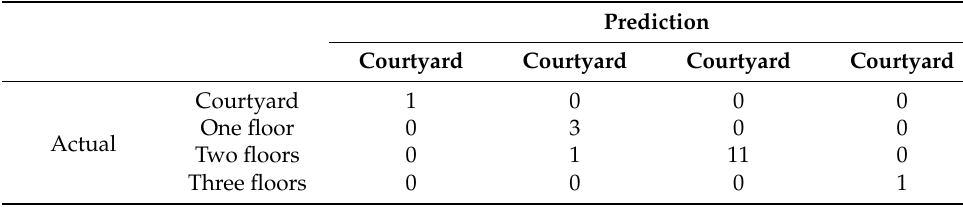
Table 5. Confusion matrix for the number of floors divided by the nDSM model.